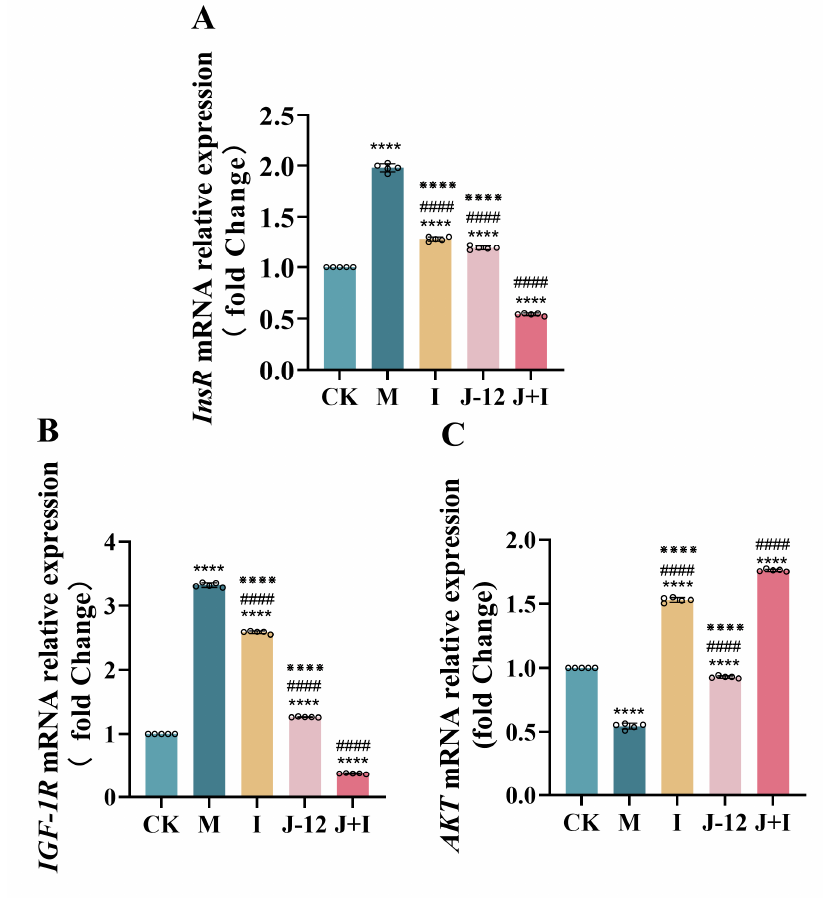
Figure 6. J-12 regulated gene expression in the central nervous system of fetuses. ( A ) Insulin receptor ( InsR ) mRNA relative expression in hippocampus. ( B ) Insulin-like growth factor-1 receptor ( IGF- 1R ) mRNA relative expression in hippocampus. ( C ) Protein kinase B ( AKT ) mRNA relative expres- sion in hippocampus. CK: control group, rats fed a standard diet. M: model group, rats fed an HFD and administered a single STZ injection prior to pregnancy and then fed a standard diet during pregnancy. I: insulin group, rats fed an HFD and administered a single STZ injection prior to preg-